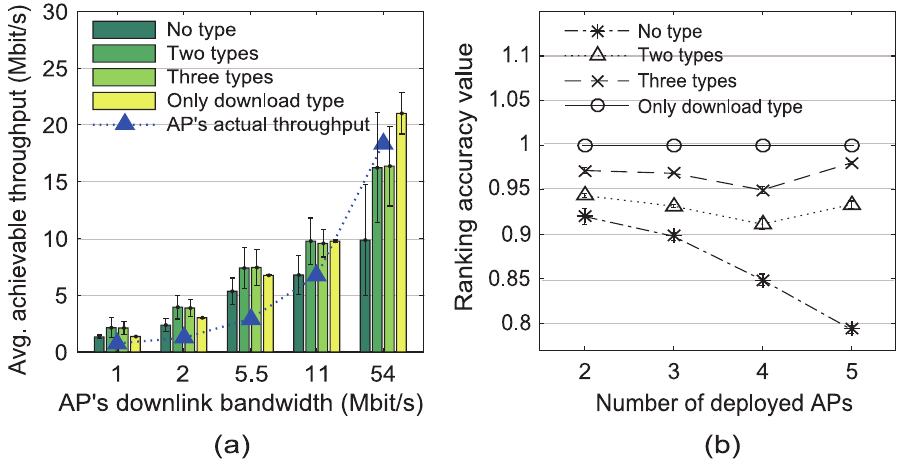
Fig 10. Achievable throughput and ranking accuracy in Scenario 1. (a) AP’s achievable throughput and (b) the ranking accuracy value corresponding to the application types considered to predict AP